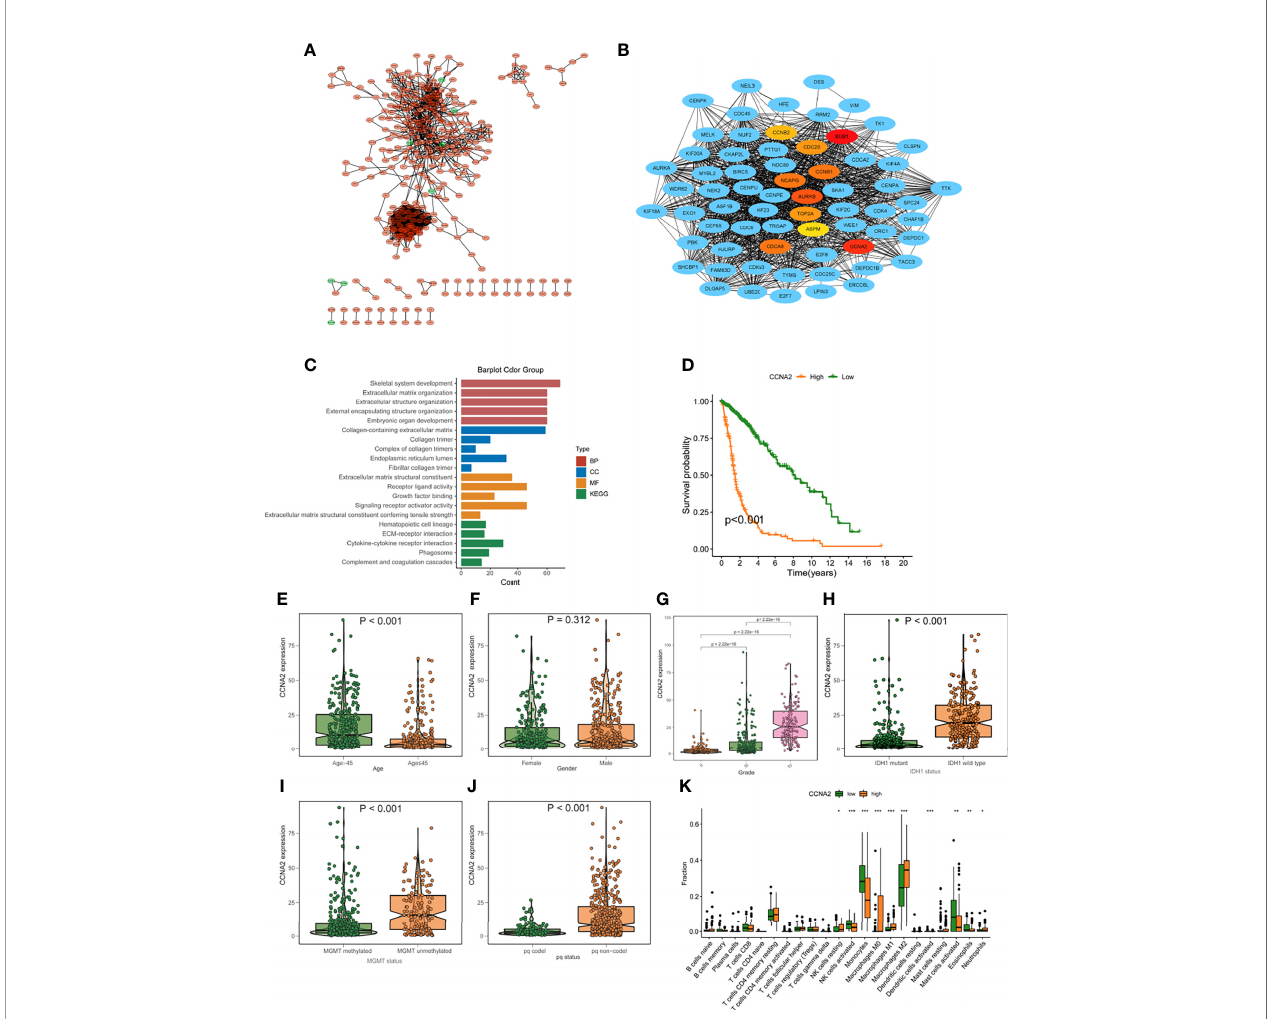
FIGURE 9 | Protein-protein interaction (PPI) graph. (A) PPI network generated by Cytoscape (red): DEGs that exhibited strongly in the excellent score category; green: DEGs that showed highly in the low-risk score group. (B) The top ten hub genes were chosen by cytoHubba. (C) The fi ndings of GO and KEGG enrichment analysis on DEGs. (D) Mortality analysis for patients divided into subgroups based on CCNA2 mRNA expression. (E-J) The difference in CCNA2 mRNA expression between various clinical characteristics, such as age (E) , gender (F) , grade (G) , IDH1 mutation (H) , MGMT promoter status (I) , and pq status (J, K) In subjects with elevated/low CCNB1 mRNA expression, the number of TME-in fi ltrating cells. *p < 0.05; **p < 0.01; ***p <